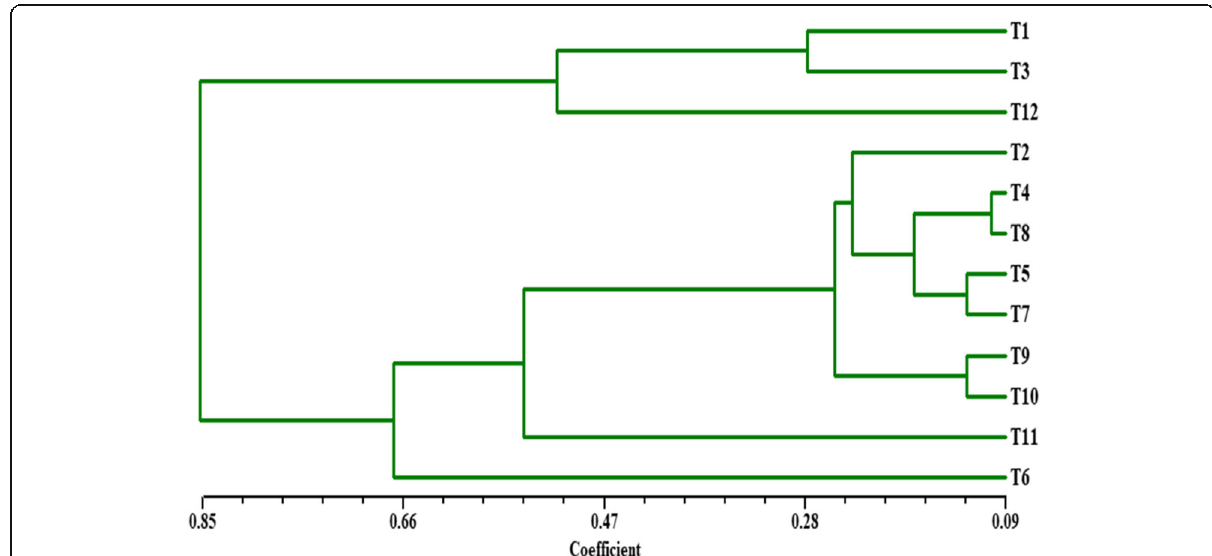
Fig. 3 Dendrogram analysis based on 10 ISSR-PCR primers that have been used for fingerprinting PCR analysis of 12 Trichoderma sp.